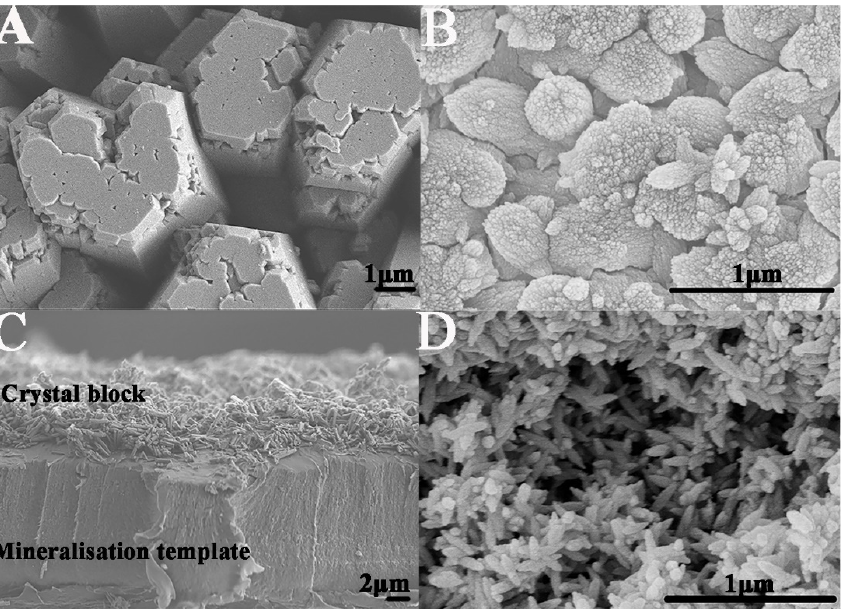
Figure 3. Scanning electron microscopy (SEM) evaluation. ( A ) Hydroxyapatite crystals (HA); ( B ) graphene oxide − hydroxyapatite crystals (GO − HA); ( C , D ) transversal and surface micrographs of GO − HA crystal block, respectively. Table 2. Concentration of different elements in pure hydroxyapatite (HA) crystals and graphene oxide-hydroxyapatite (GO − HA) crystals fabricated with different concentrations of